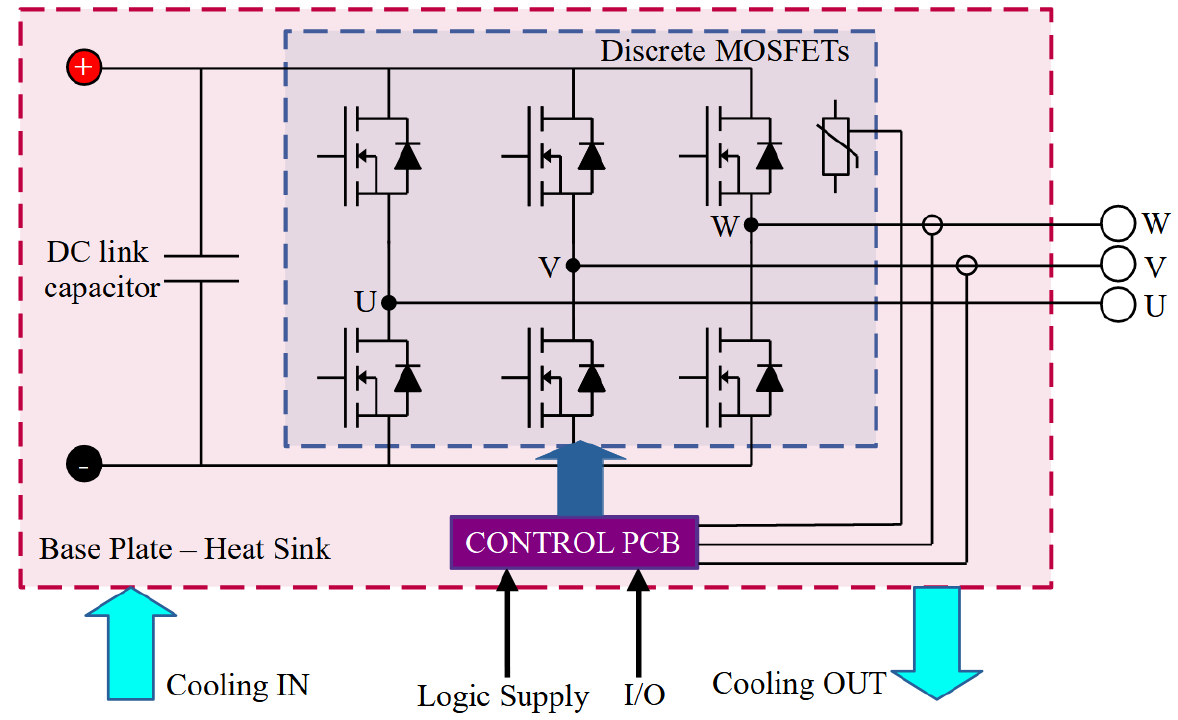
Figure 12. emDrive 500 inverter